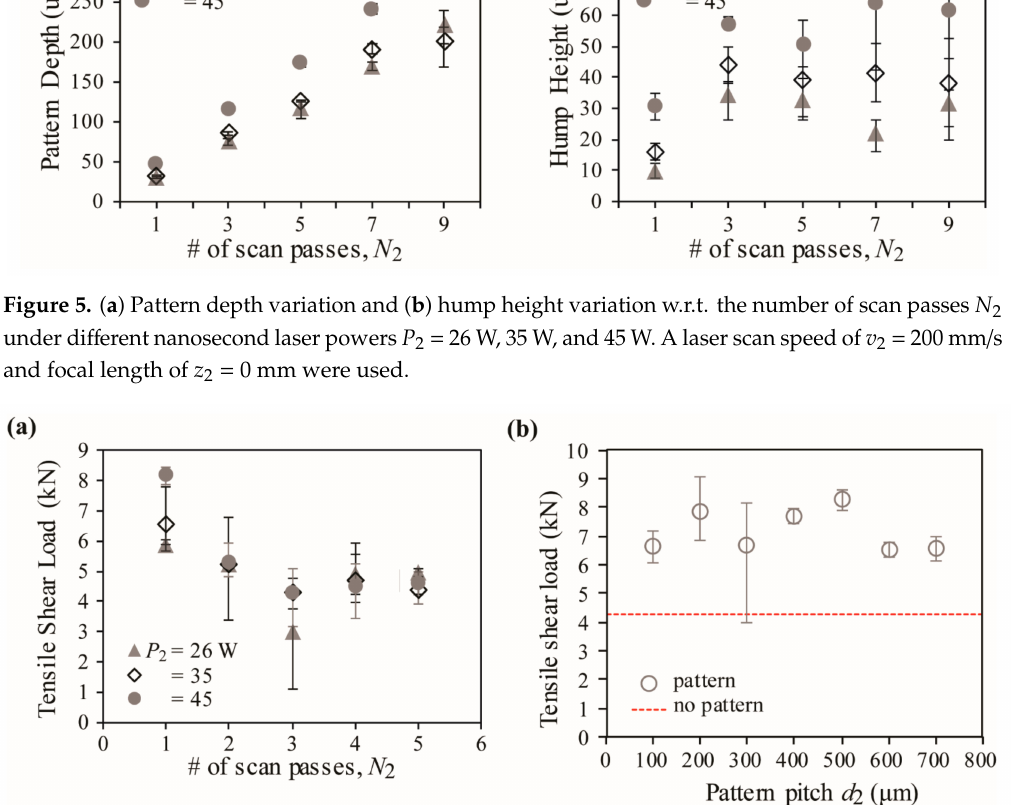
Figure 6. ( a ) Tensile shear load variation w.r.t. the number of scan passes N 2 under di ff erent laser powers P 2 = 26 W, 35 W, and 45 W. d 2 = 500 µ m, v 2 = 200 mm / s, and z 2 = 0 mm were used. ( b ) Tensile shear load variation w.r.t. the pattern pitch d 2 . Laser power P 2 = 45 W, N 2 = 1, v 2 = 200 mm / s, and z 2 = 0 mm were